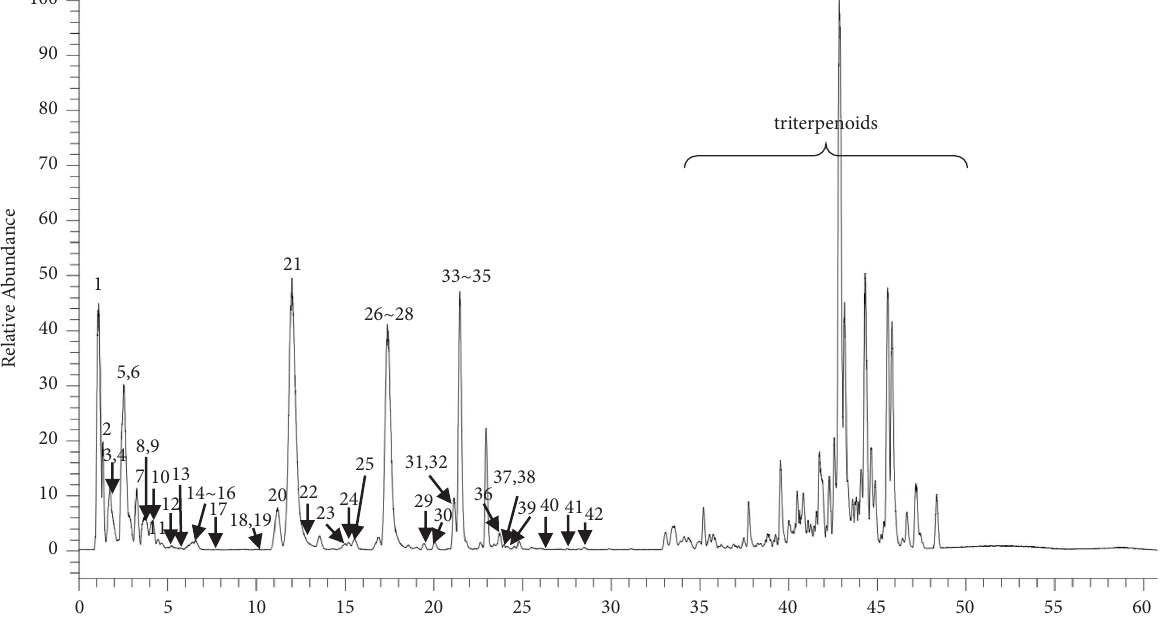
Figure 3: Te total ion chromatograms of the LCP extraction solution in negative ion